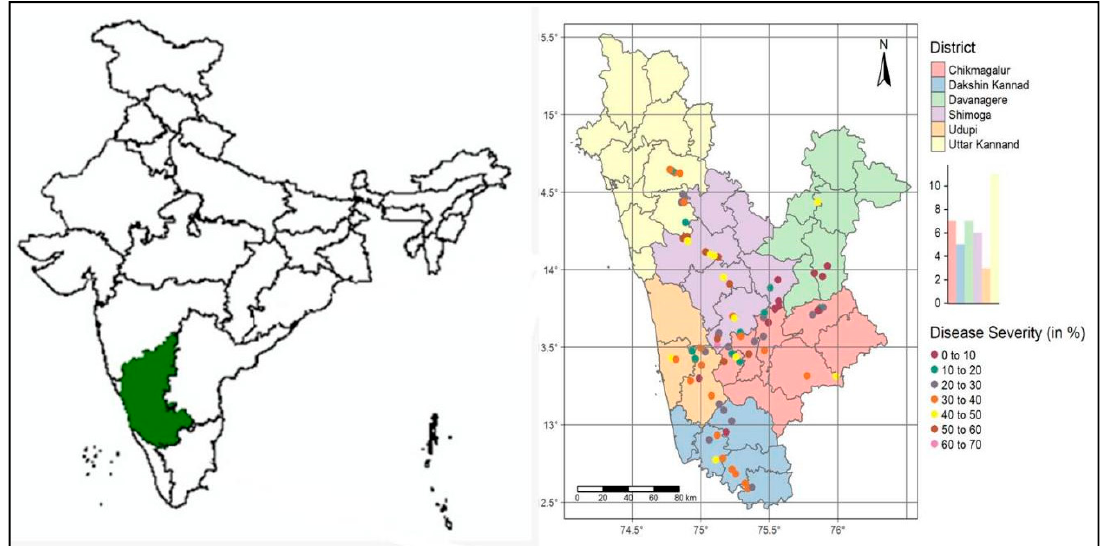
Figure 1. Featured map of India (left), Karnataka (green colored), and locations monitored for fruit rot disease (FRD) in Karnataka (right). Different colored circles ( n = 83) represent FRD sampling sites in Karnataka during the monsoon seasons of 2018 and 2019.